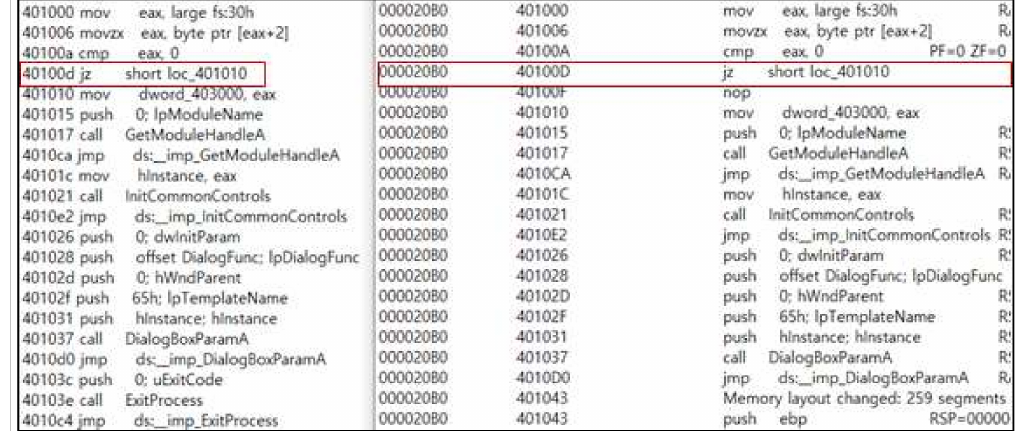
Figure 3. Trace extracted via IPT and debugger.